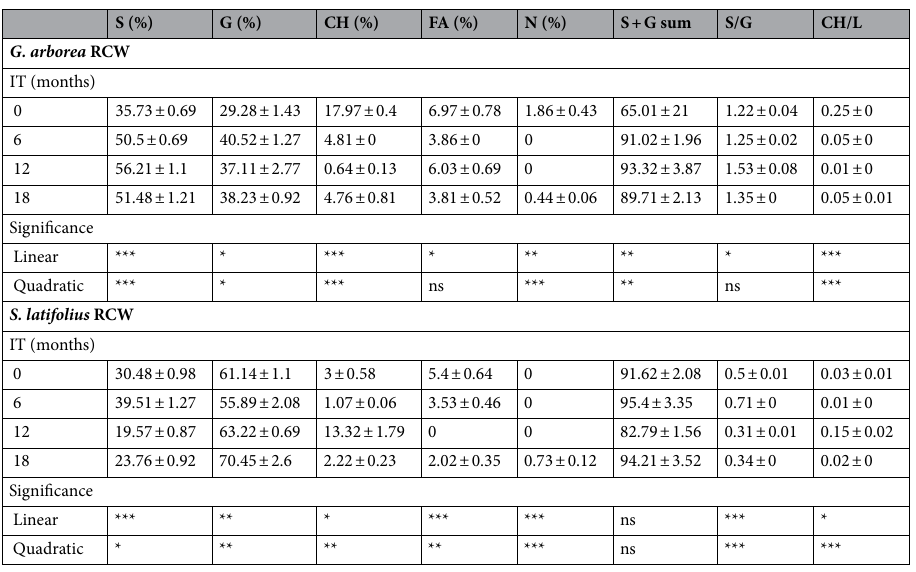
Table 2. Lignin units (G and S), carbohydrate (CH), fatty acid (FA) and nitrogen containing coumpounds (N) molar contents from thermochemolysis using TMAH and SG sum, S/G and CH/L (L, lignin) ratios from thermochemolysis using of the RCW samples at different stages of residence in soils; the values presented are averages of triplicate measurements. Results are expressed as means ± standard errors in triplicate; IT, RCW Incubation times (months) in soil, *Contrasts significant at the 0.05 level, **Contrasts significant at the 0.01 level, ***Contrasts signifi cant at the 0.001 level, ns = not significant.